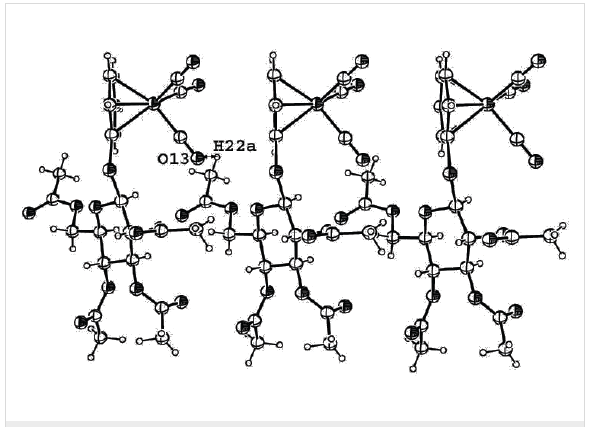
Figure 7: ORTEP-plot of the asymmetric unit showing three mole- cules of compound 2j and 30% probability ellipsoids; the arrows show the nonclassical H-bonds between O13 and H22a.